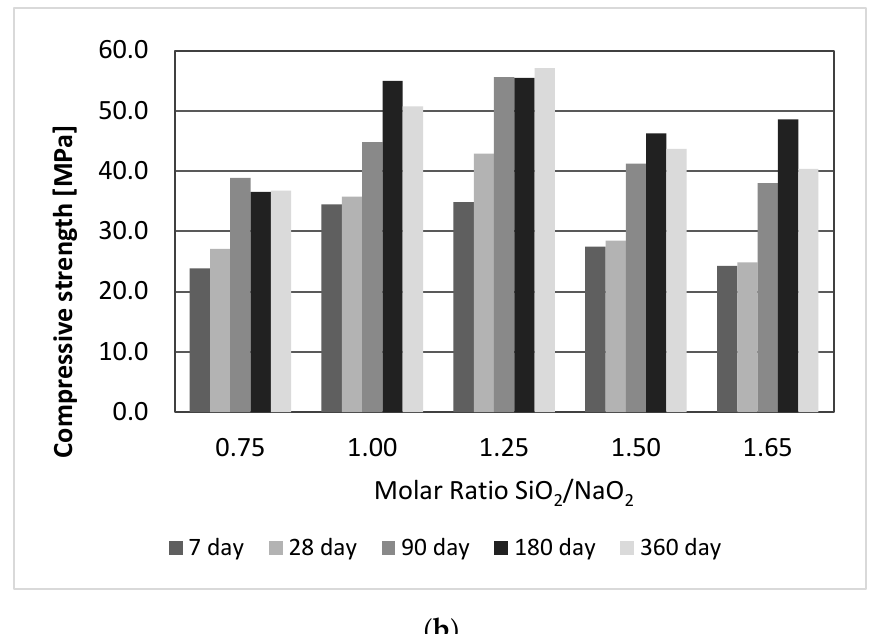
Figure 5. Flexural strengths ( a ) and compressive strengths ( b ) of samples with different SiO 2 /Na 2 O molar ratio.